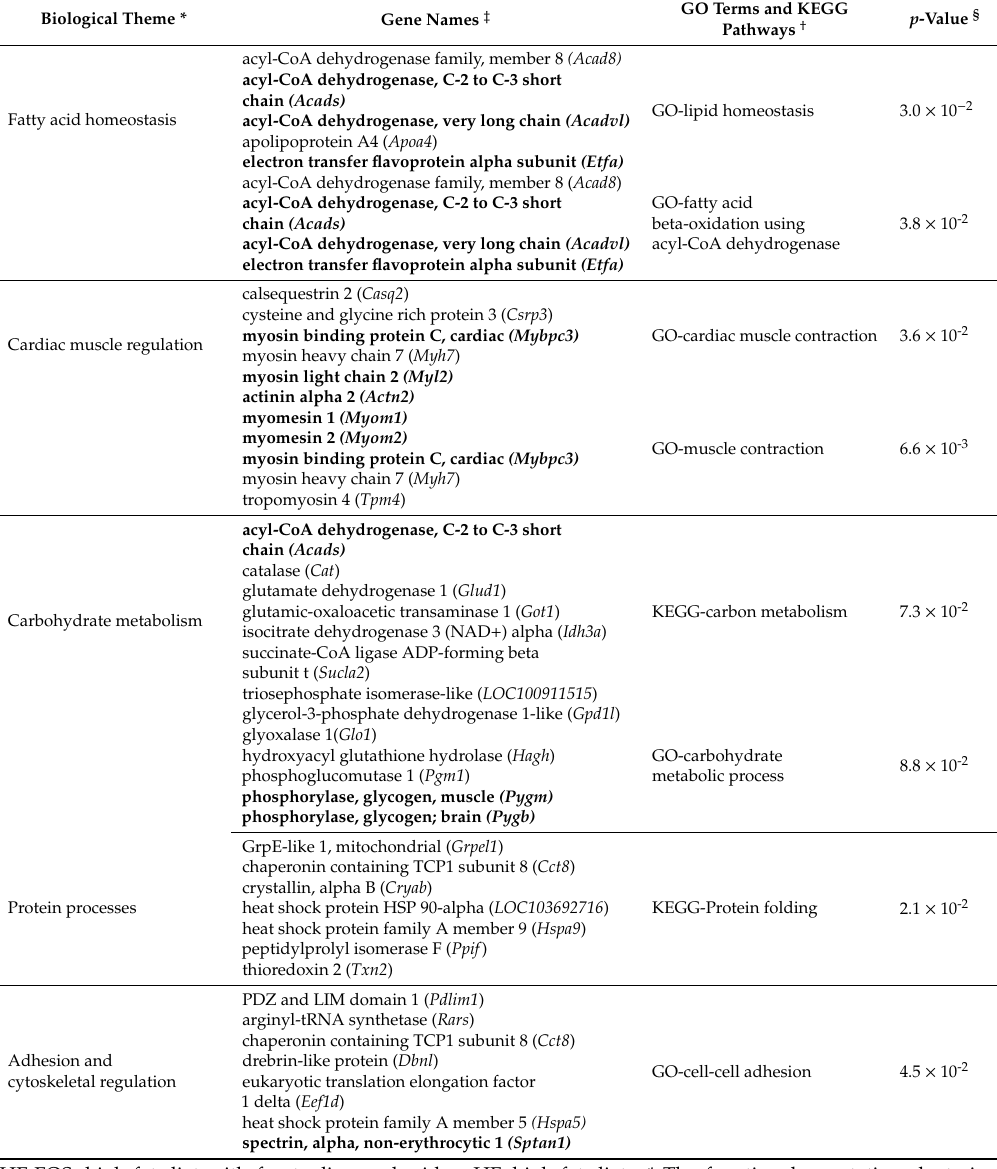
Table 4. Enriched GO terms and KEGG pathways of di ff erentially expressed proteins between HF-FOS and HF diet groups in heart tissue according to biological